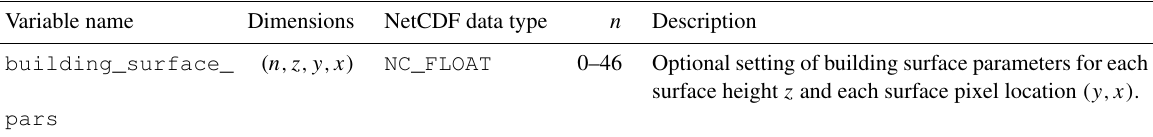
Figure 1. Illustration of LOD1 and LOD2 hierarchy for the LAI around Berlin Ernst-Reuter-Platz. Panel (a) shows the determined vegetation_type classification, which involves automatic setting of an LAI for all pixels classified as vegetation (LOD1), shown in panel (b) . Panel (c) shows LOD2 information of the LAI distribution transferred by the field vegetation_pars . Source: Sentinel-2, FIS Broker (dl-de/by-2-0: https://www.govdata.de/dl-de/by-2-0, last access: 26 October 2020) and © OpenStreetMap contributors 2018. Distributed under a Creative Commons BY-SA License. Table 3. List of LOD3 variables that can be specified in the static driver